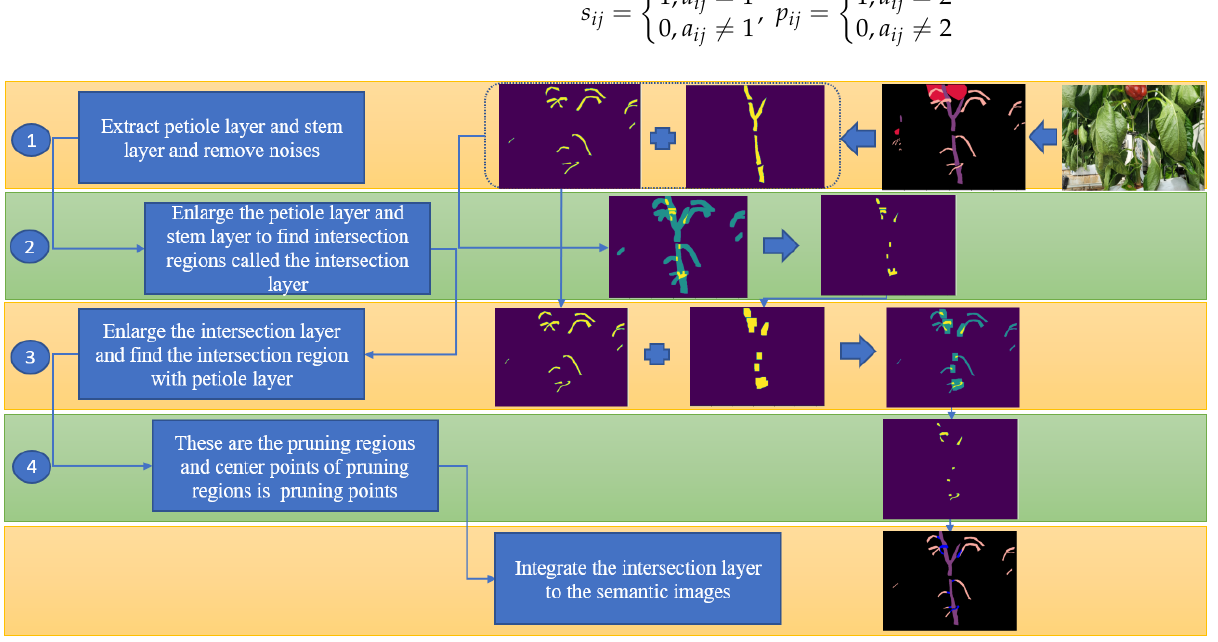
Figure 5. Four steps to detect pruning regions and pruning points in 2D semantic images.